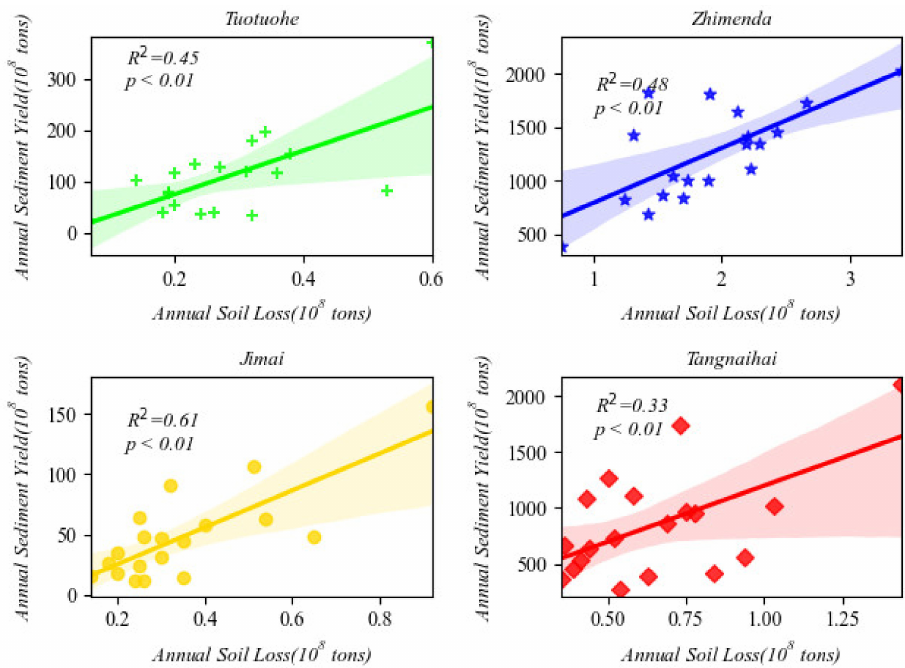
Figure 4. Verification of soil water erosion and sediment